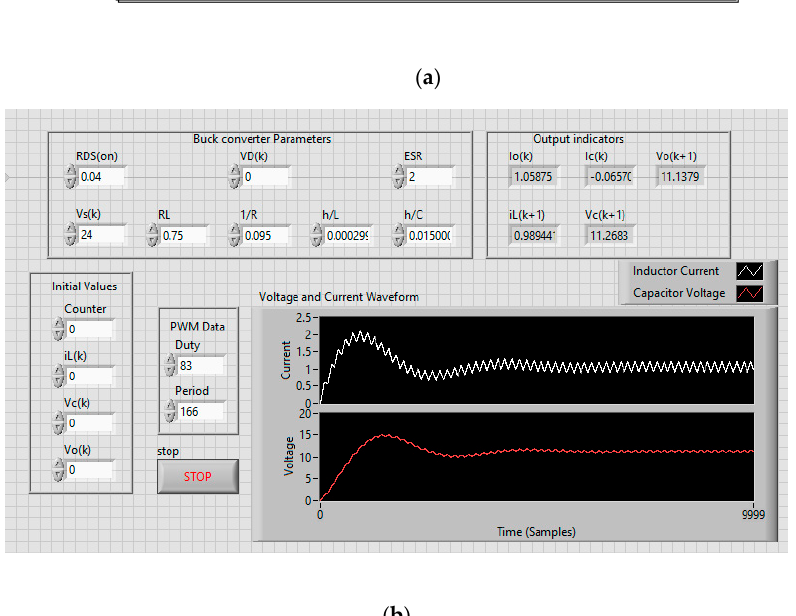
Figure 7. Block diagram of the programmed buck converter. ( a ) Discrete model; ( b ) Front panel of the simulated buck converter.